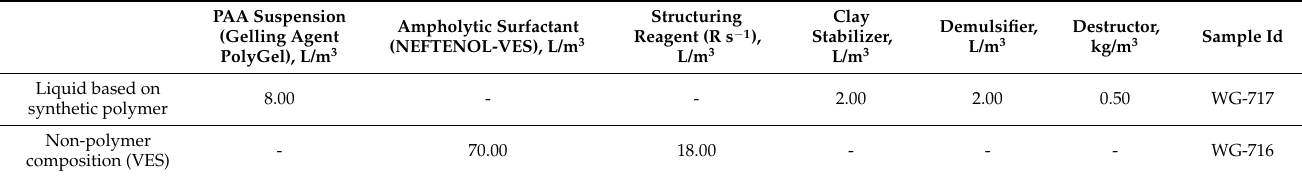
Table 3. The composition of fracturing water-based fluids